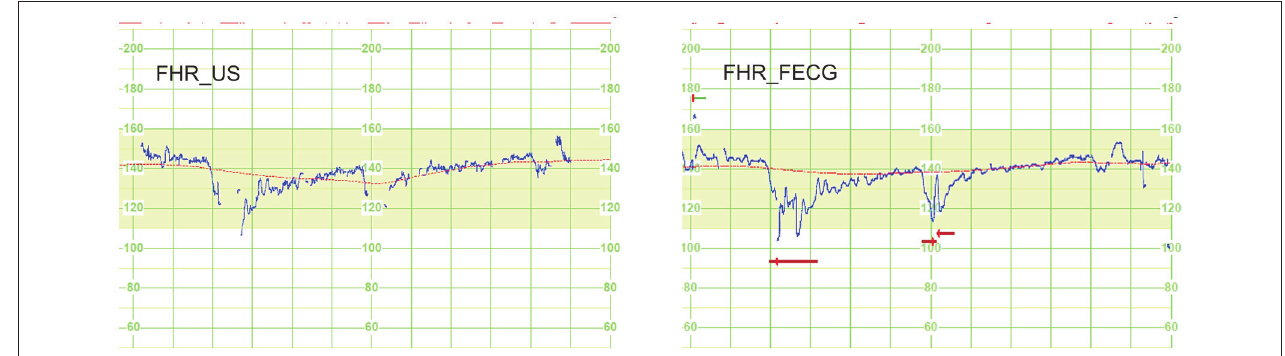
FIGURE 3 | An example of a 12-min fragment of signal pair—result of an indirect comparison to evaluate the impact of the FHR signal acquisition method on clinically relevant parameters, determined by a computer-aided fetal monitoring system. The autocorrelation technique, commonly used in the US method to determine the signal periodicity, is often not able to follow the rapid decrease of FHR_U signal related to deceleration, which results in signal loss episodes. This, in turn, causes that the deceleration is not recognized, because it does not meet the established criteria of amplitude and duration. Graphic markers of the analysis results illustrate the signal loss (above the curve), the estimated FHR baseline (line fitted on FHR curve) and detected deceleration episodes (horizontal bars under the curve).